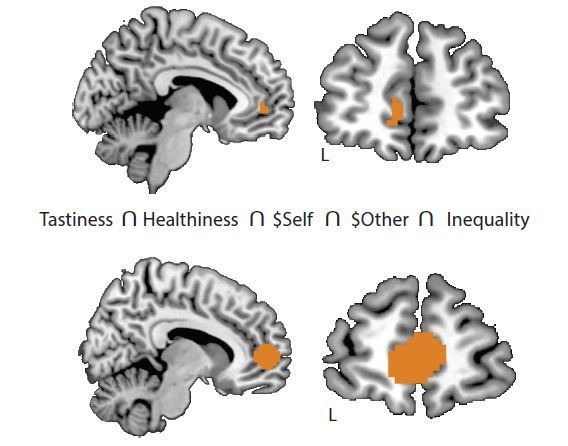
The figure illustrates two VMPFC-ROIs used for the supplemental analyses.